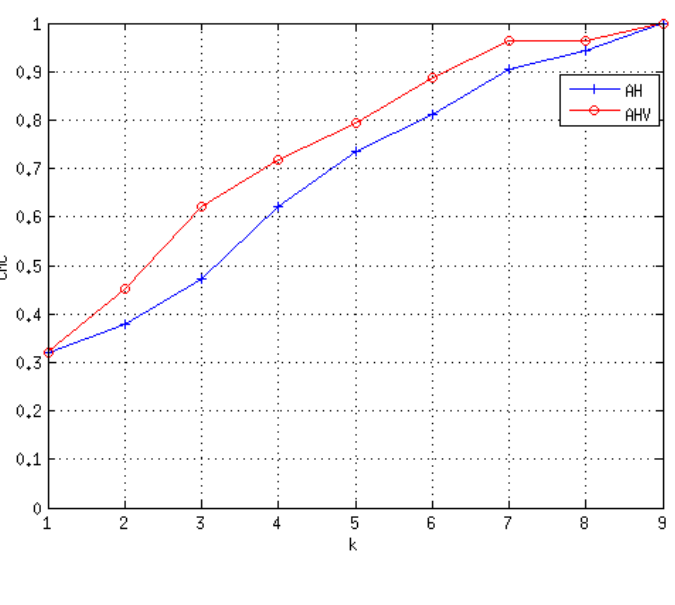
Figure 12. Cumulative Matching Curve for SequenceB